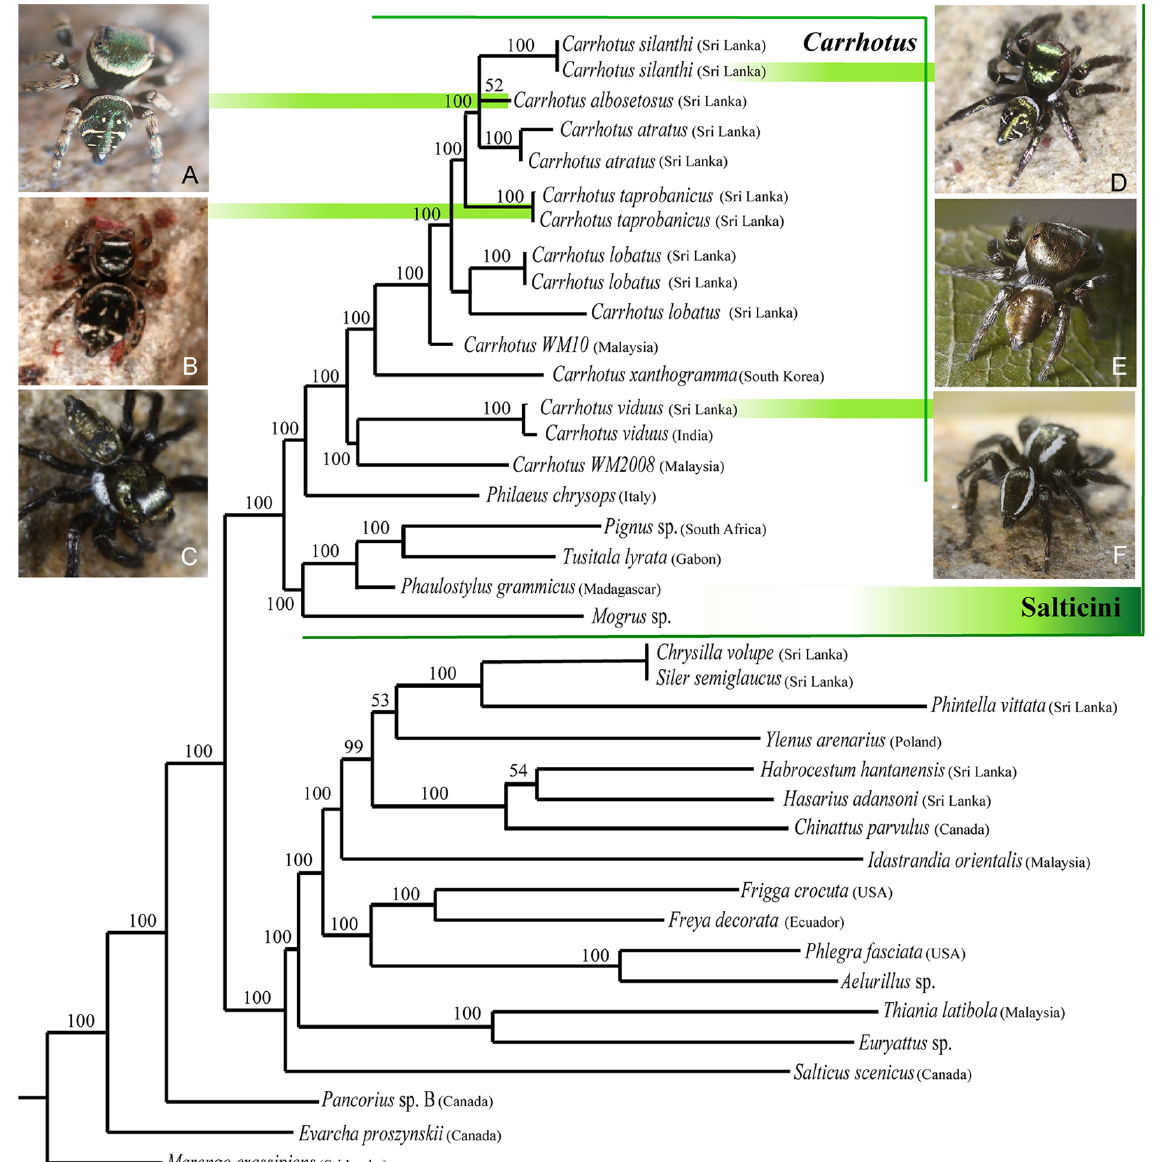
Fig 1. The single most likely tree obtained by ML analysis of the combined molecular data in RAxML– VI–HPC. The numbers above the nodes represent bootstrap values (only values 50 and above are given). Nodes that are unsupported have been collapsed. Collection country is given if available. In life images: A . Carrhotus albosetosus sp. nov. from Pillikutuwa. B . C. taprobanicus Simon, 1902 from